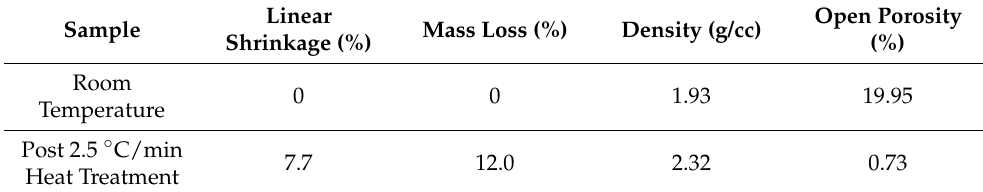
Figure 3. Micrographs of polished ( A ) and fractured ( B ) ASH-G composites after heating to 900 °C for 5 h using heating/cooling rates of 2.5 °C/min. Table 3. Physical Changes Due to Initial Heating to 900 °C.